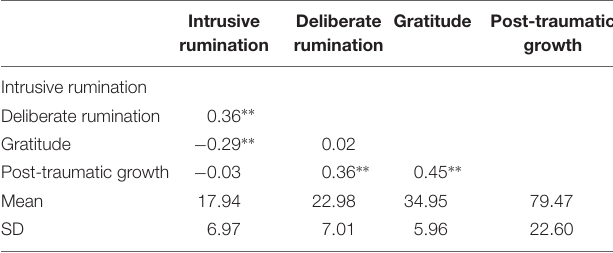
TABLE 2 | Correlations, mean, and standard deviation among variables ( N =